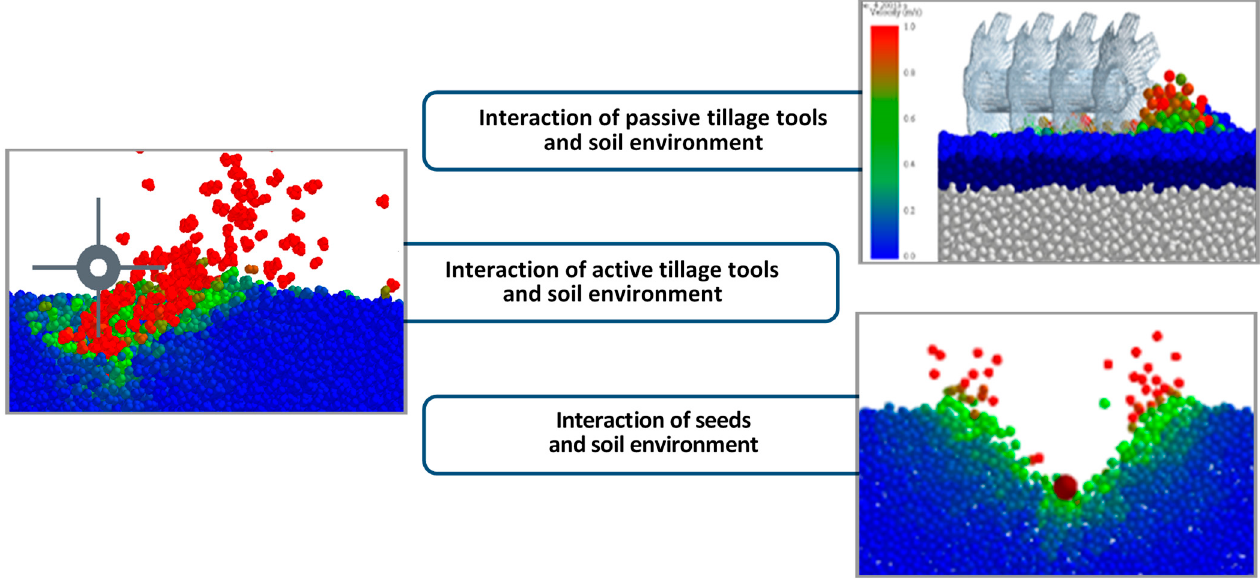
Figure 6. Simulation of interaction with the soil environment by the DEM.